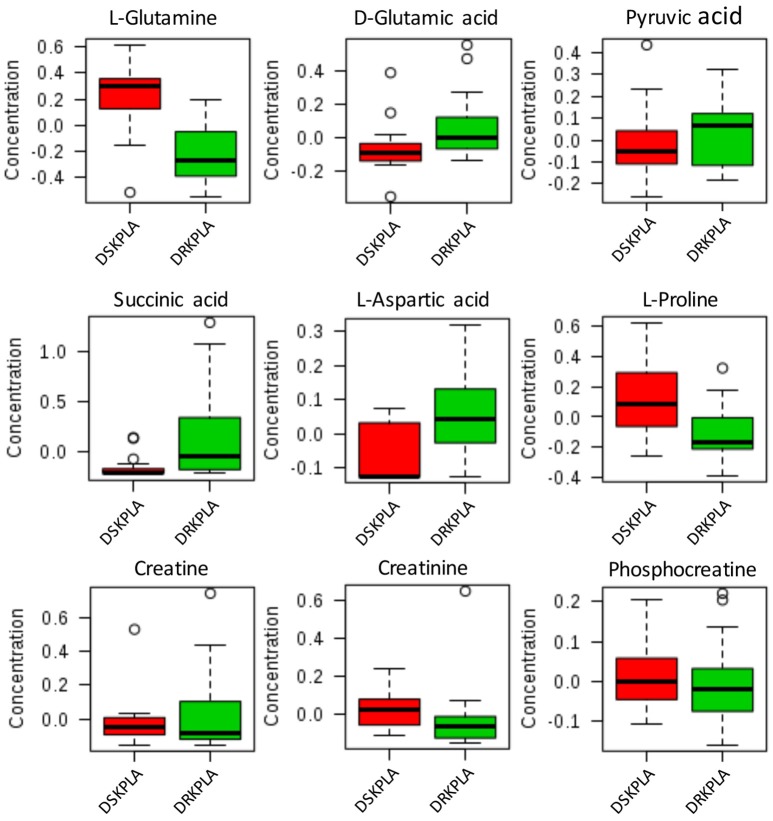
Boxplot of the relative concentrations of the significantly altered metabolites (p < 0.05) in the sera of DRKPLA (green) and DSKPLA (red) patients. The bar plots show the normalized values (the mean ± one standard deviation). The boxes range from the 25% to the 75% percentiles, and the 5% and 95% percentiles are indicated as error bars. Single data points are indicated by circles. The medians are indicated by the horizontal lines within each box.